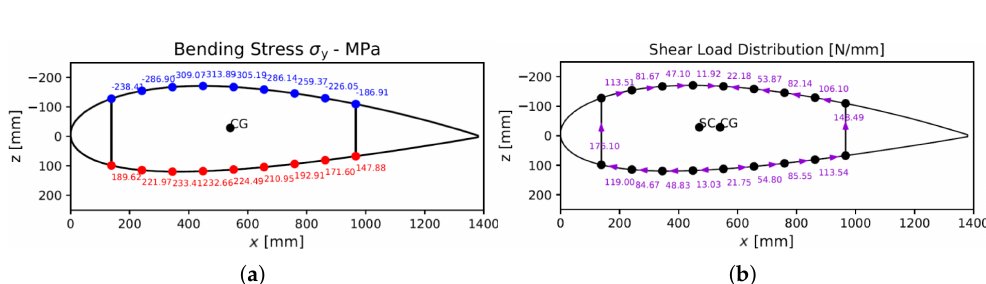
Figure 7. ( a ) Axial stress distribution due to bending loads; and ( b ) shear flow distribution due to shear